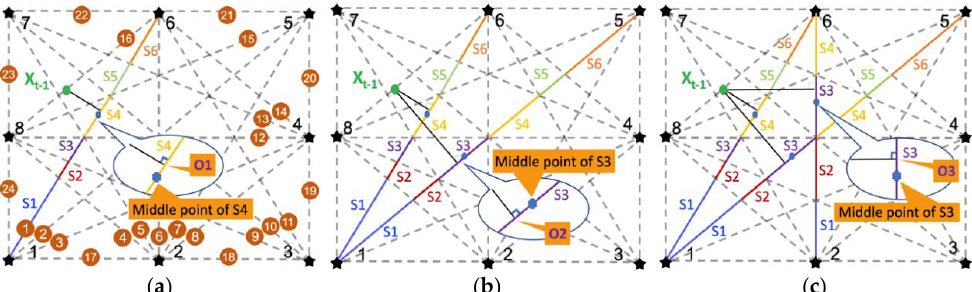
Figure 5. This is a figure. Schemes follow the same formatting. Illustration of the proposed geometric midpoint (GM) algorithm. Target estimation when ( a ) the quantity of triggered link is equal to one. ( b ) The quantity of triggered links is equal to two. ( c ) The quantity of triggered links is equal to three.